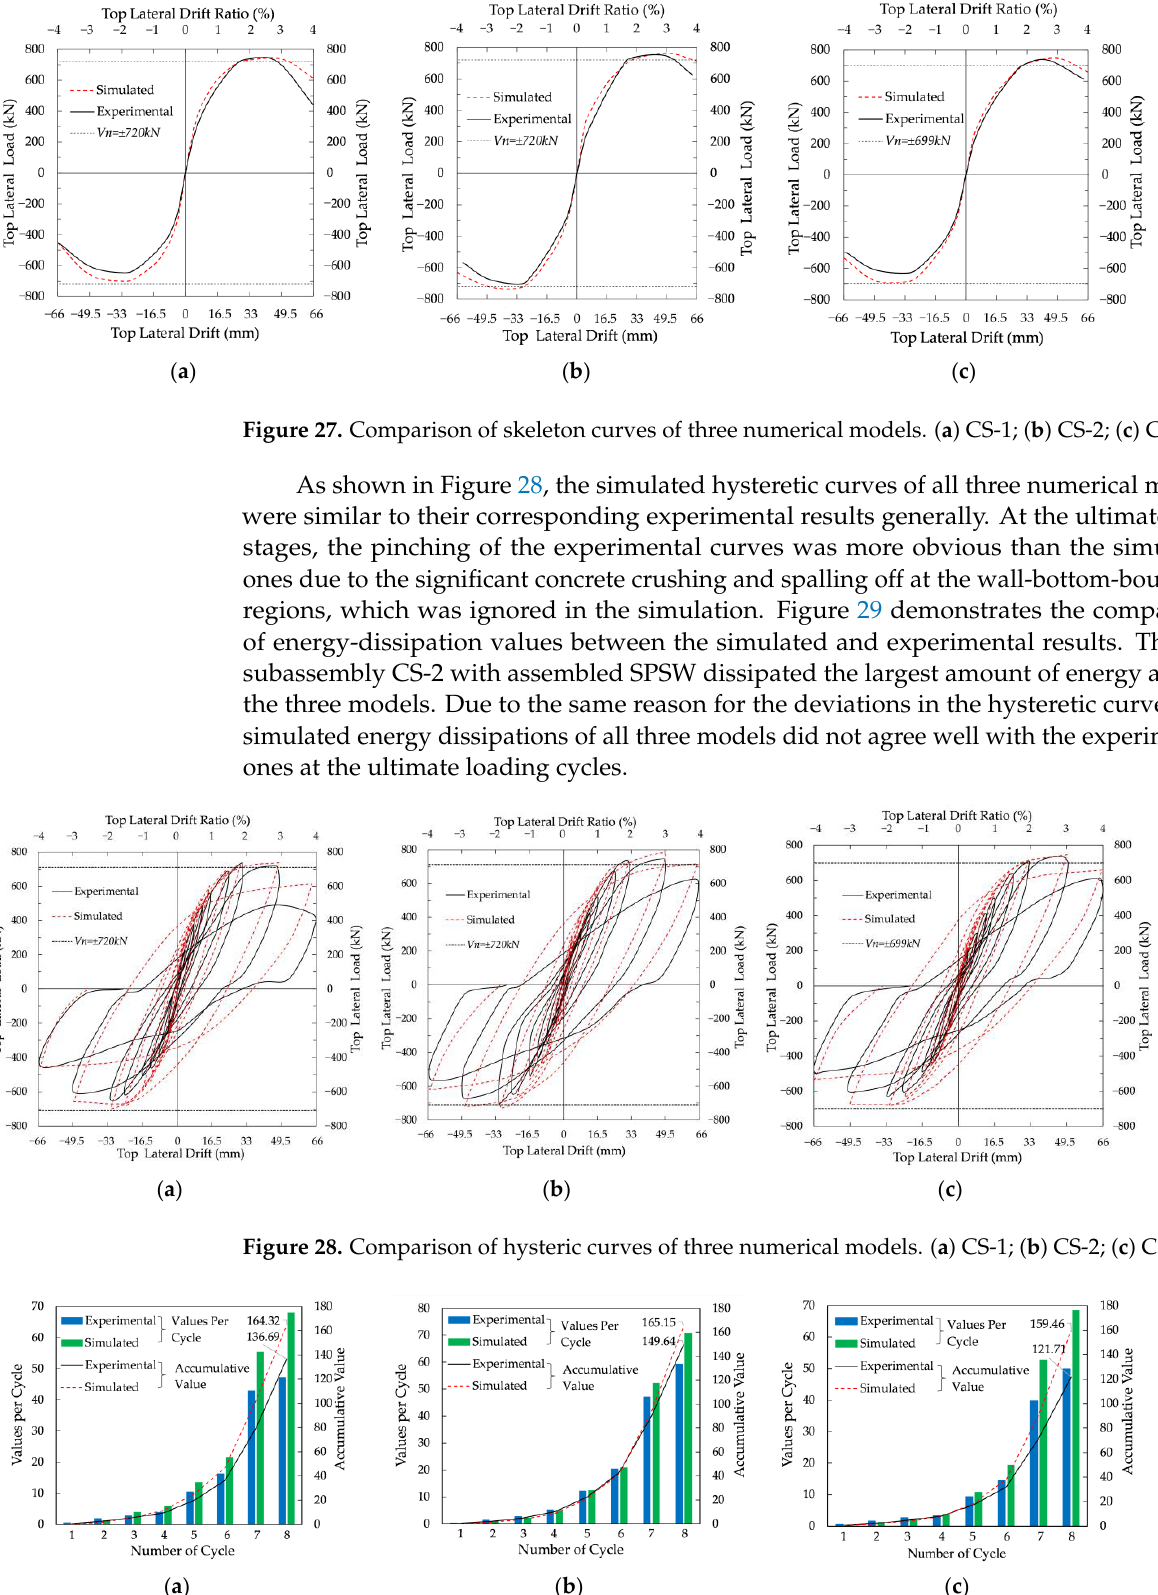
Figure 29. Comparison of energy dissipation values of three numerical models. ( a ) CS-1; ( b ) CS-2; ( c ) CS-3.